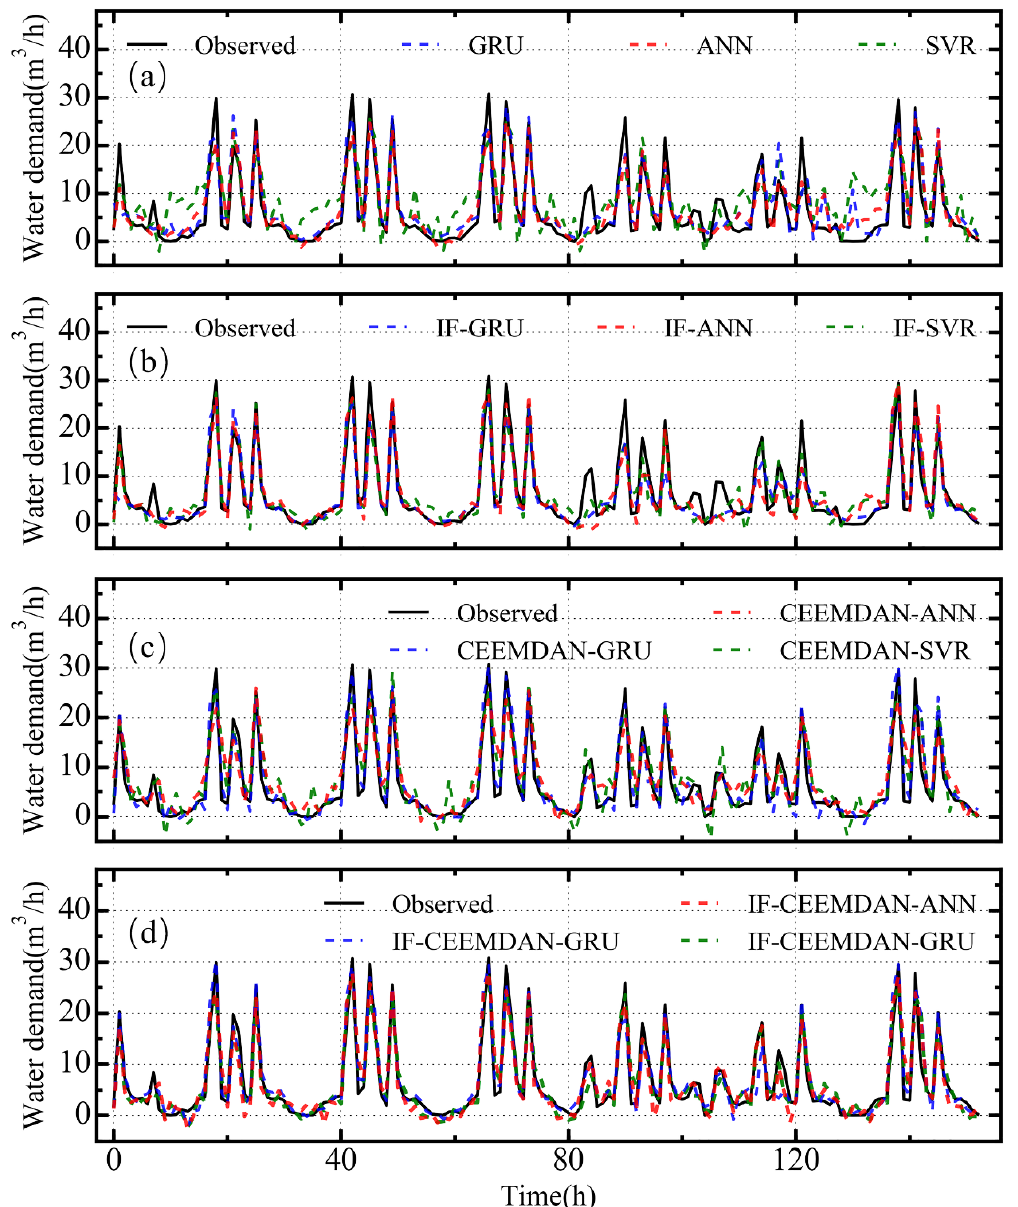
Figure 6. Water demand forecasting results of: ( a ) GRU, Artificial Neural Network (ANN), and Support Vector Regression (SVR); ( b ) Isolation Forest (IF)-GRU, IF-ANN, and IF-SVR; ( c ) CEEMDAN-GRU, CEEMDAN-ANN, and CEEMDAN-SVR; and ( d ) IF-CEEMDAN-GRU, IF-CEEMDAN-ANN, and IF-CEEMDAN-SVR. Table 2. Comparison of CPU time for different models.